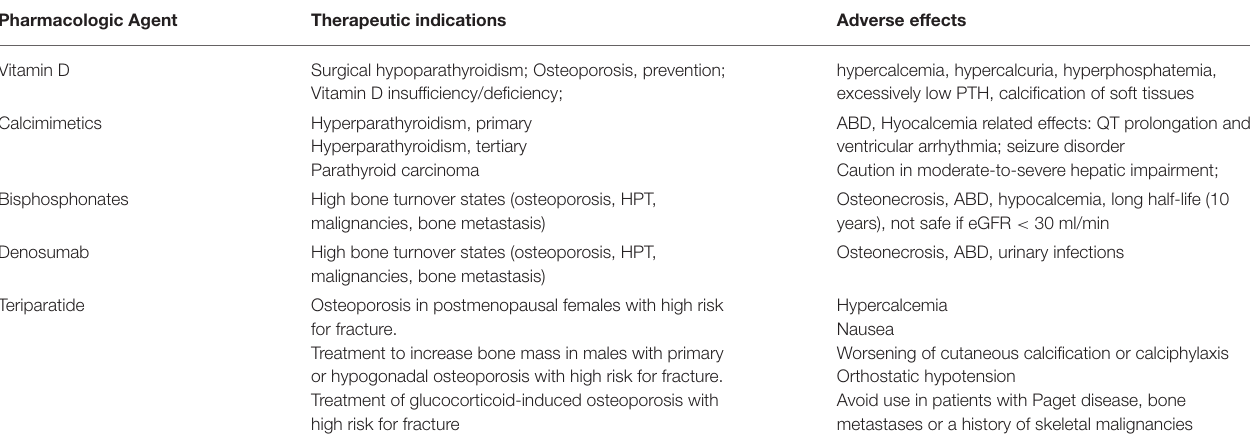
TABLE 3 | Pharmacologic characteristics of the main therapeutical agents for